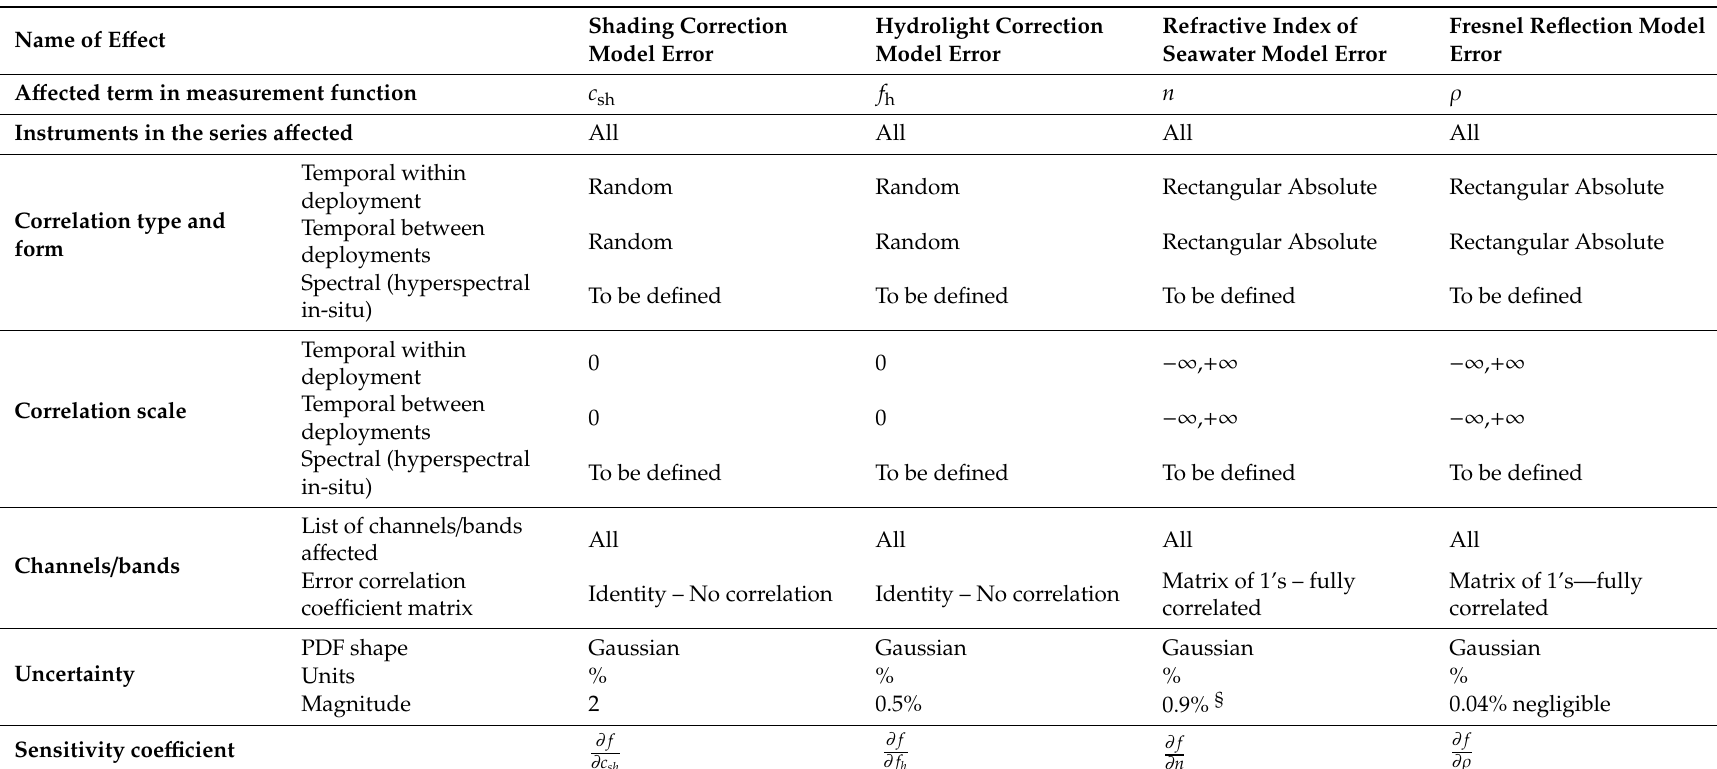
Table A4. E ff ects tables for models’